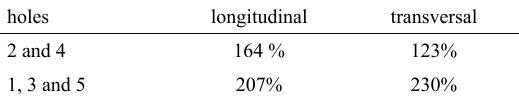
Table 3. Increases of residual